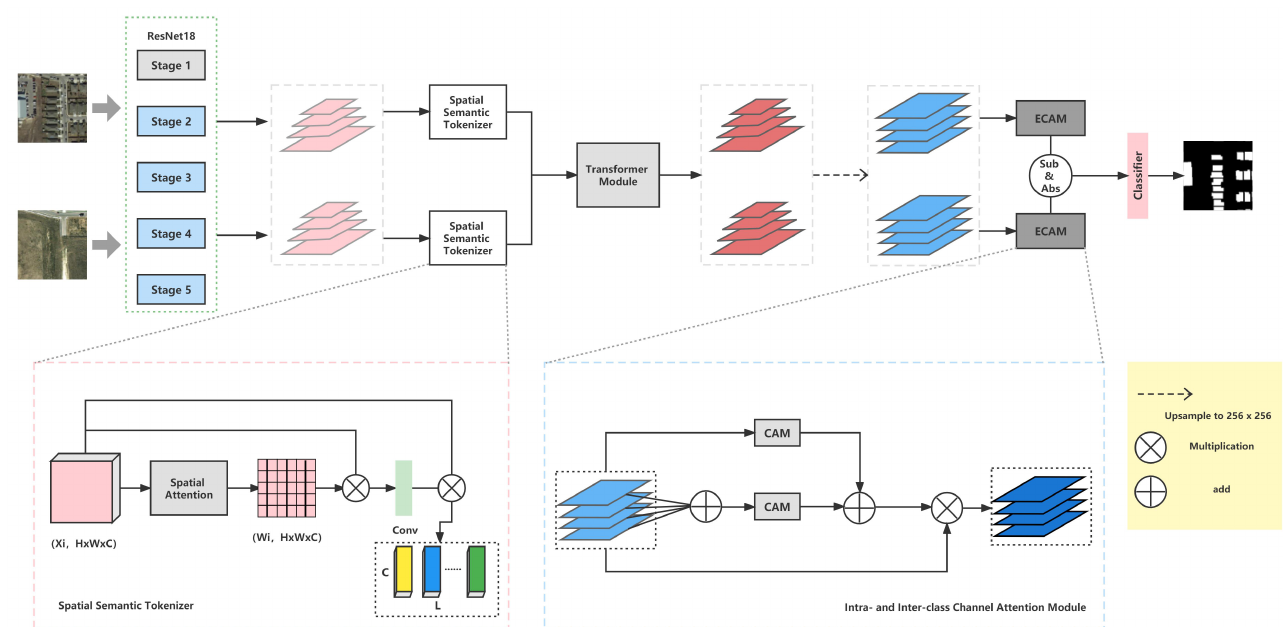
Figure 2. The diagram of the proposed MFATNet. The bi-temporal remote sensing images are fed into a Siamese ResNet18, which obtains two sets of feature maps for each of the last four stages. The feature maps are then fed into the transformer module to learn long-range dependencies after being processed into compact semantic tokens by the SST module. The context-rich tokens are then mapped and upsampled to the raw size, and the resulting change map is obtained by the IICAM module after eliminating the gaps and further choosing more discriminative